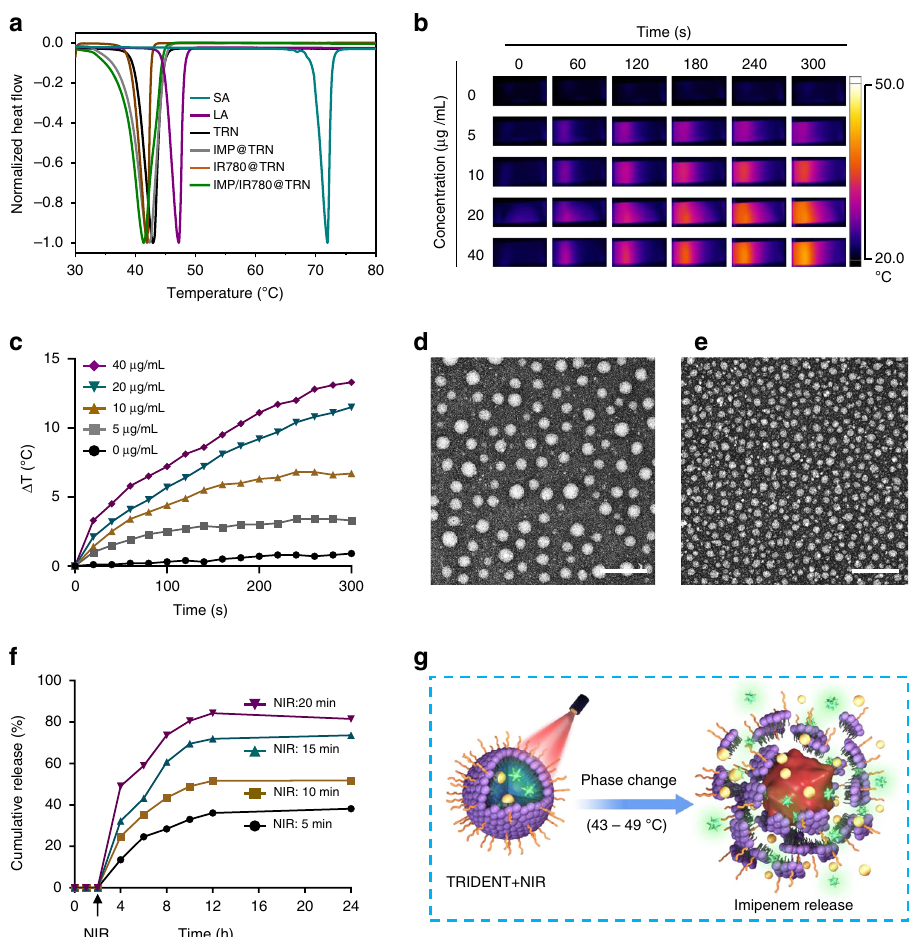
Fig. 3 Thermo-responsive characteristics of TRIDENT. a DSC curves of stearic acid (SA), lauric acid (LA), TRN, IMP@TRN, IR780@TRN and IMP/ IR780@TRN. b Thermal images of TRIDENT solution under NIR irradiation (808 nm, 0.5 W cm − 2 ) at selected time points. c Heating curves of TRIDENT solutions under the NIR irradiation. TEM images of TRIDENT, d before, and e after irradiation for 5 min. Scale bars: 200 nm. f In vitro cumulative release pro fi le of IMP from TRIDENT under NIR irradiation with different time. g Schematic representation of the thermal phase-change of TRIDENT and the resulting imipenem release. Source data are provided as a Source Data fi